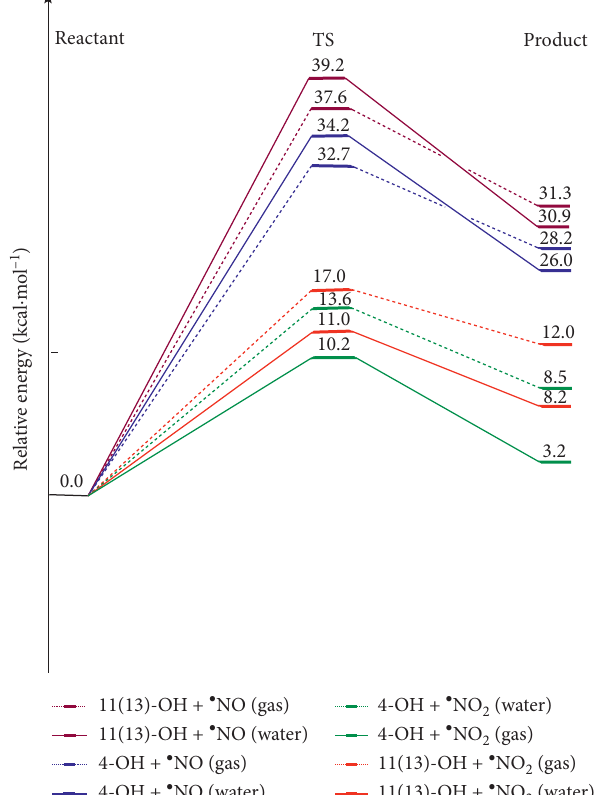
Figure 8: Energy diagram for • NO and • NO 2 radical attack on hydroxy groups of RSV at B3LYP/6-311++G(d, p) level of